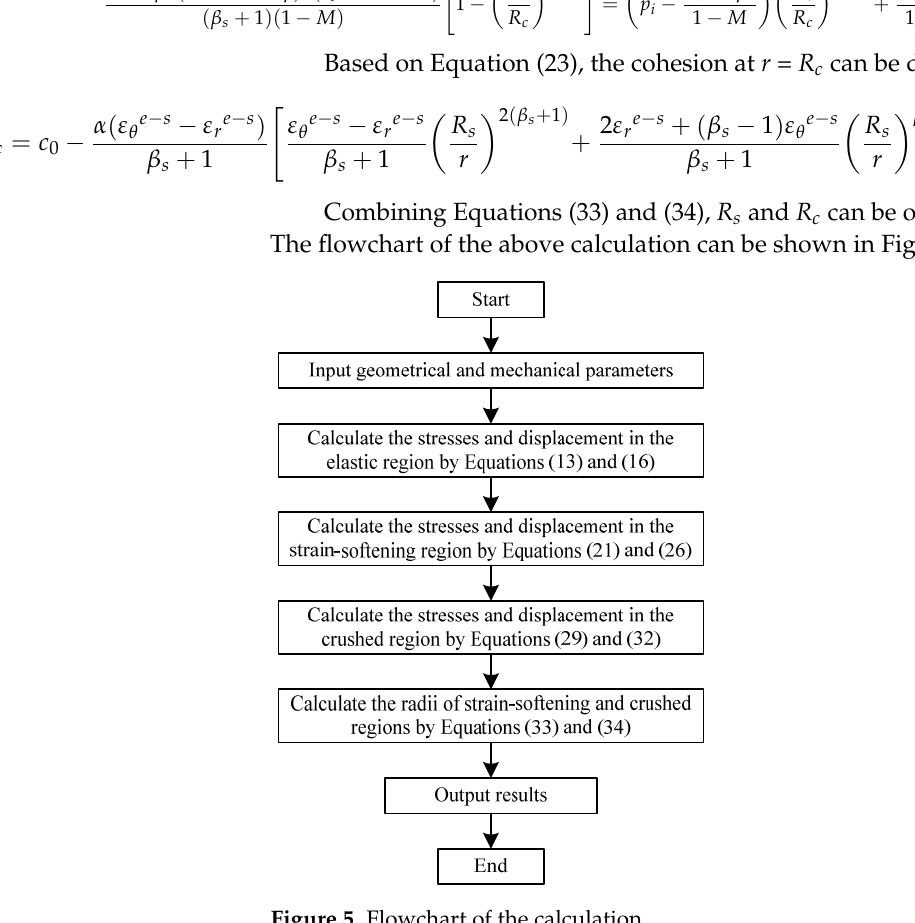
Figure 5. Flowchart of the calculation.